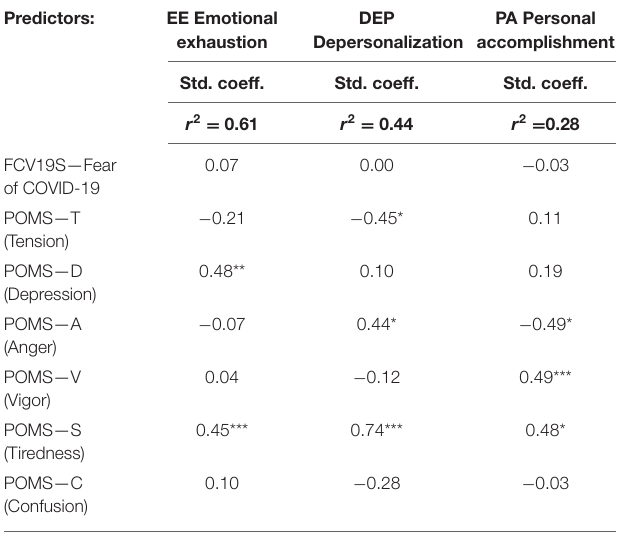
TABLE 6 | Multiple regressions for the three variables of the MBI-HSS in healthcare professional samples.